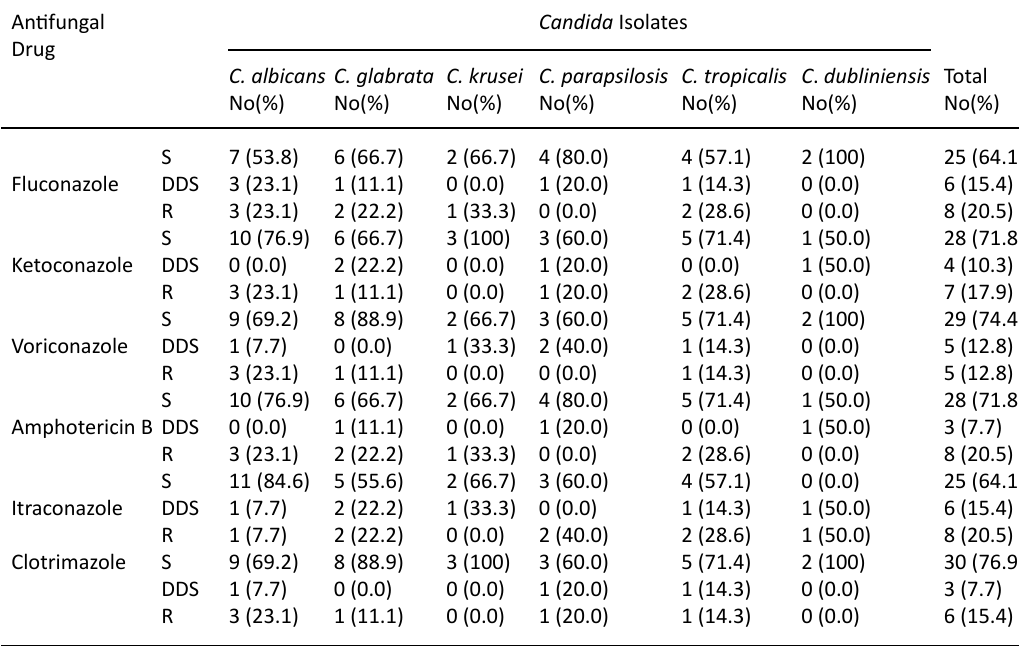
Table 5. Antifungal Susceptibility of Candida Isolates from Diabetic (Candiduric) Patients (n = 39) Antifungal Candida Isolates Drug